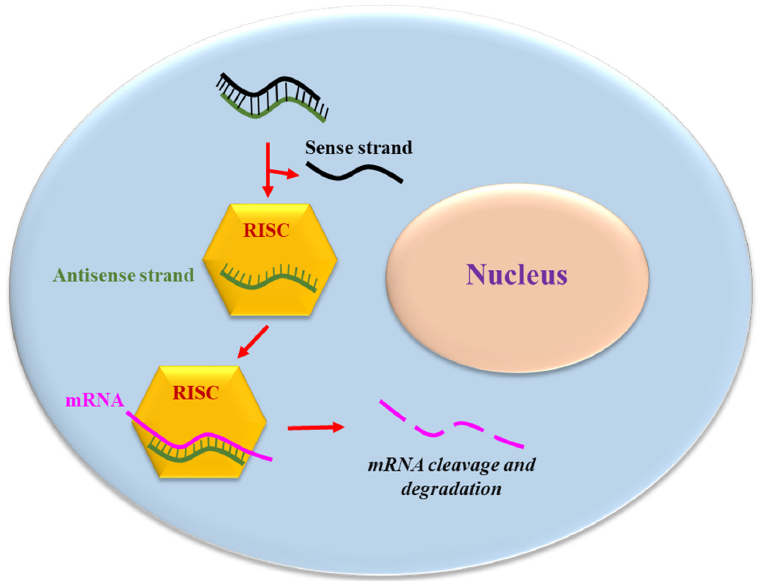
Figure 1. The siRNA mechanism of action. The antisense strand of the siRNA is up-taken by a catalytic protein complex (RNA-induced silencing complex, RISC). The antisense strand drives RISC to a target mRNA, which results in specific, RISC-mediated mRNA degradation.